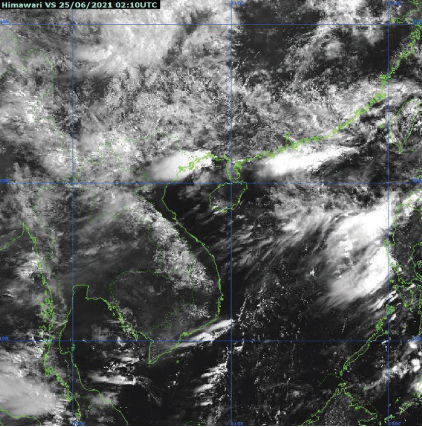
Figure 3: Cloud image (white color) at 14 :10 25 june 2021 (source: